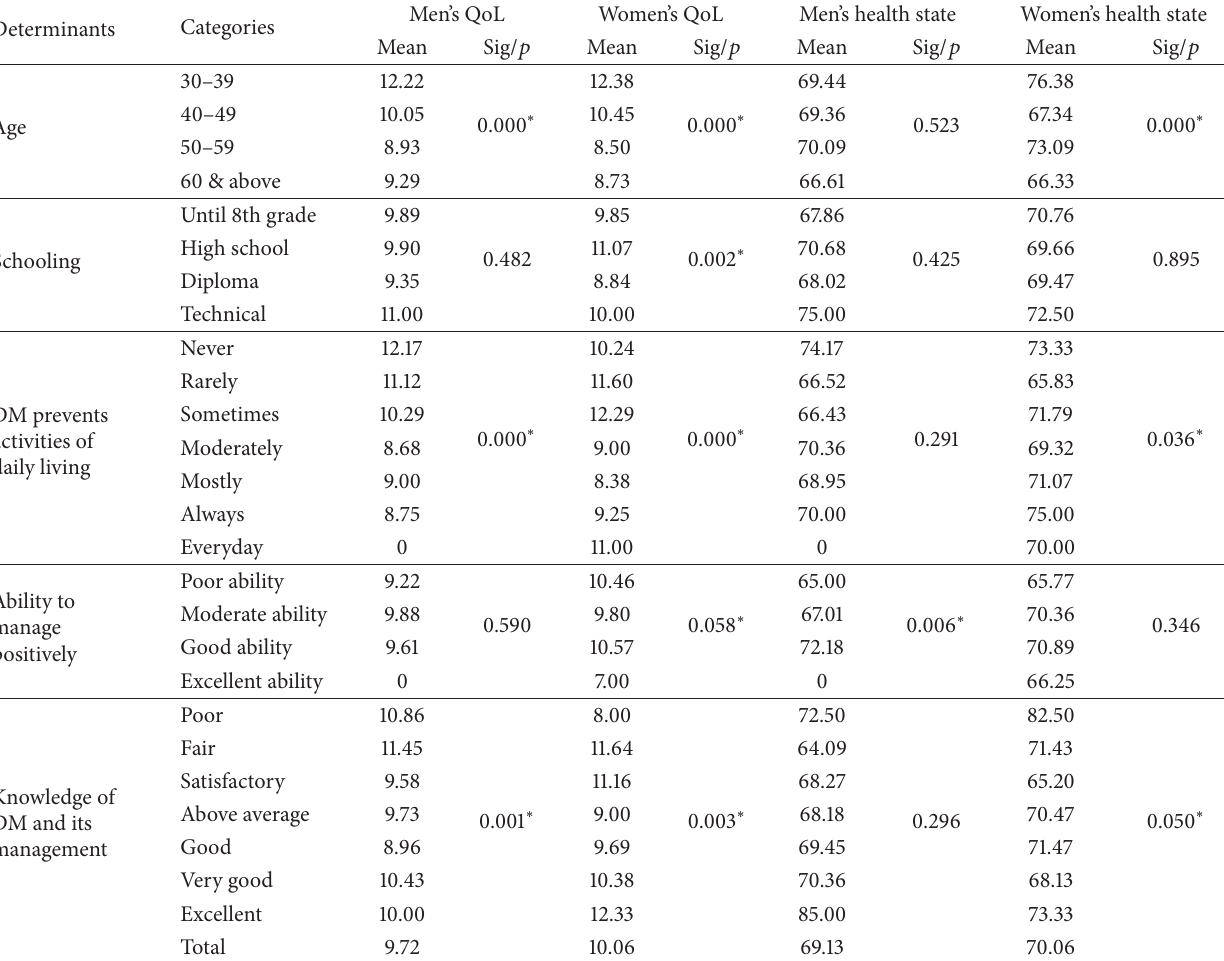
Table 2: Personal characteristics and total QoL and health state among men and women.